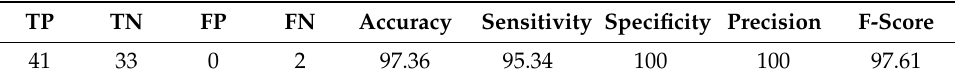
Table 9. Diagnostic accuracy of VH-IVUS for detecting TCFA based on cardiologist decision and SVM (TP: true positive, FP: false positive, FN: false negative, TN: true